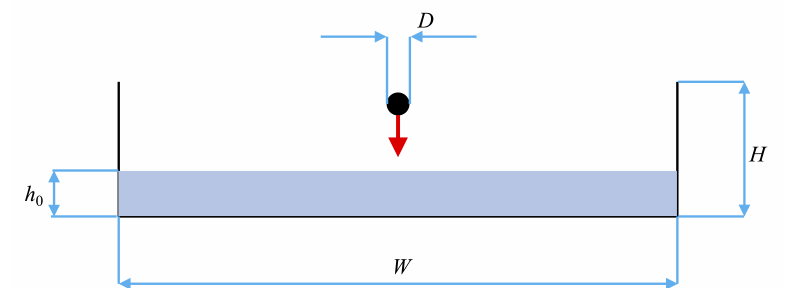
Figure 5. Representation (not to scale) of the computational domain used for validation.